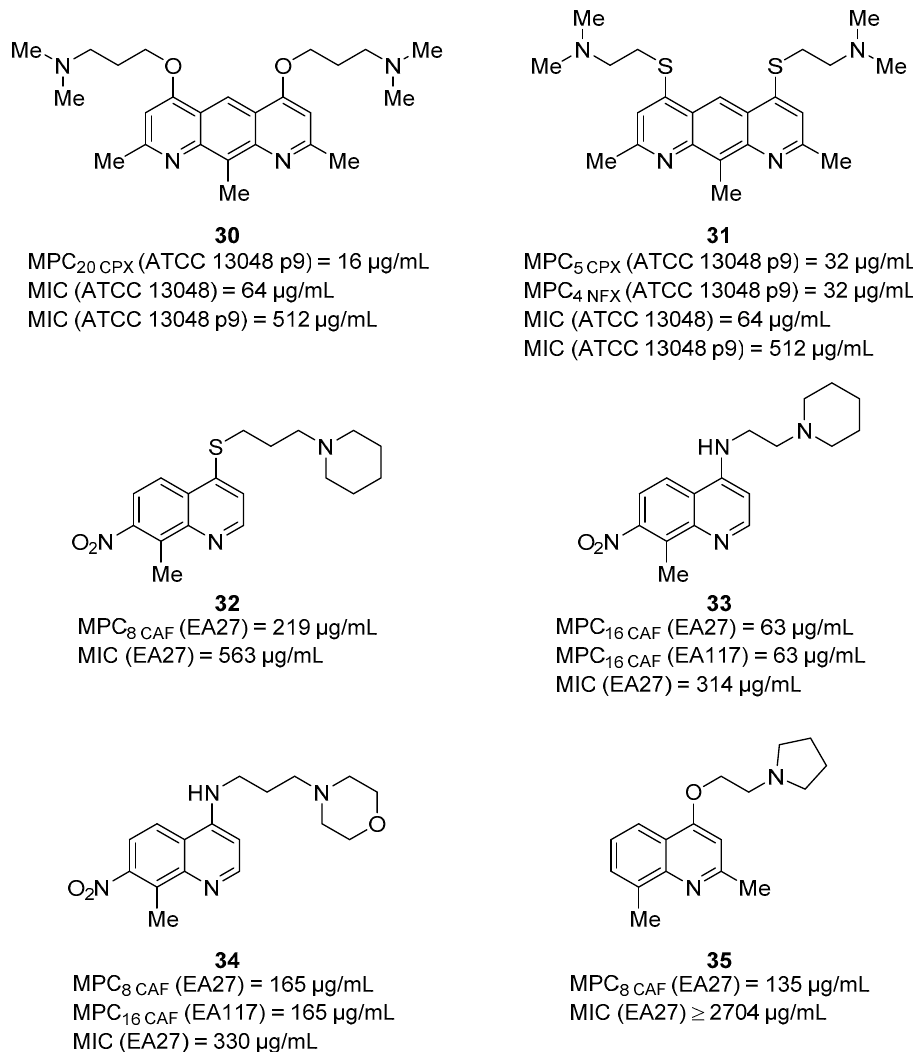
Figure 12. Quinoline derivatives ( 30 – 35 ) reported as Gram-negative EPIs. Few years later, Ghisalberti et al. reported a series of chloroquinolines as potential EPIs towards antibiotic-resistant E. aerogenes isolates [94]. Among the six synthesized derivatives, decorated with different alkylamino chains at nitrogen atom at the C-4 position, three compounds ( 36 – 38 —Figure 13) at 0.310 mM (86–95 µ g/mL) showed a significant reduction in CAF MIC (by 8-fold) against EA27 and EA5 strains and by 32, 16 and 8-fold, respectively, against the CM-64 strain. In parallel, all three compounds did not show any antibacterial activity on their own and any synergistic effect when tested in combination with CAF against the wild-type E. aerogenes ATCC